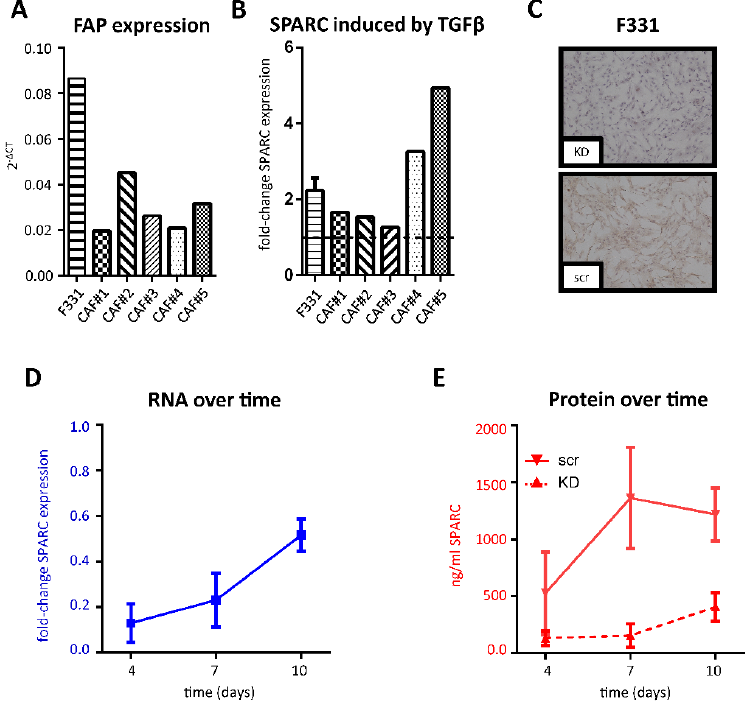
Figure 2. Fibroblast-derived SPARC: RNA was isolated from semiconfluent fibroblast cultures and FAP mRNA was analyzed by qRT-PCR relative to GAPDH as the housekeeping gene ( A ). F331 and CAFs were treated with 5 ng / mL TGF β for a total of 72 h. SPARC mRNA expression was plotted as fold change to negative control and shown for F331 fibroblasts ( n = 3) and for CAFs (single experiments); numbering of CAFs indicate the respective patient from whom the fibroblasts were isolated ( B ). In addition, F331 cells transfected with SPARC siRNA or scr control were grown on glass slides and stained by IHC with a SPARC specific mAB after 72 h ( C ); size bar = 100 µ m. Knockdown e ffi ciency in F331 cells was monitored over a total of 10 days ( D ) SPARC mRNA expression after siRNA transfection was calculated as fold-change ratio of KD to scr ( n = 3). ( E ) SPARC protein levels secreted into the medium supernatant were evaluated by ELISA and plotted for both scr (solid line) and KD (dashed line) ( n = 2). All data are pooled from experiments using 2 di ff erent siRNAs and given as mean ± SD. KD, knockdown; scr, scrambled control; siRNA, small interfering